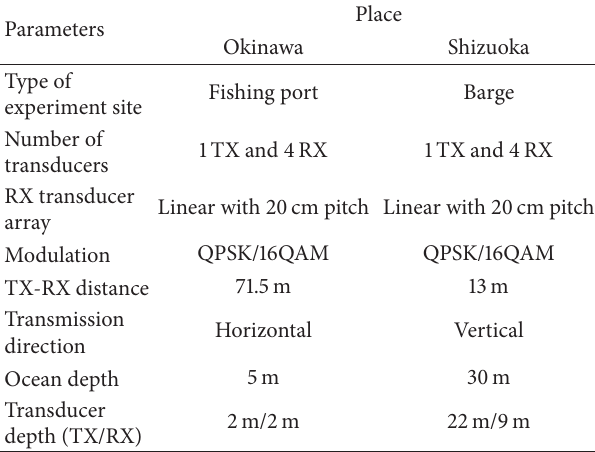
Table 2: Ocean experiment